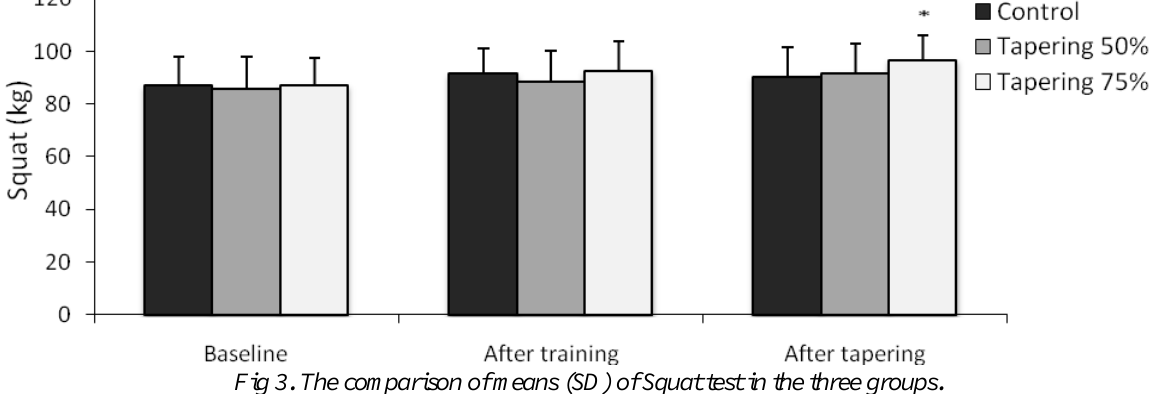
Fig 3. The comparison of means (SD) of Squat test in the three groups. Significant among control and tapering 75% are indicated with (*).